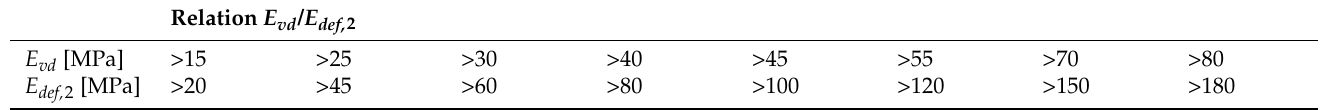
Table 2. Recommended relation between E vd vs. E def, 2 used in Germany.